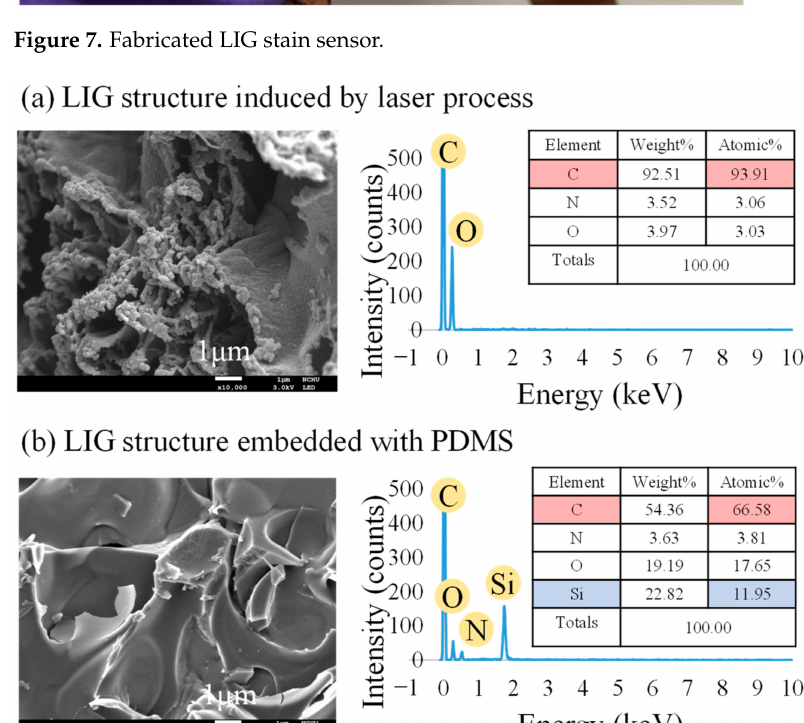
Figure 8. SEM images and EDS results for ( a ) the LIG structure and ( b ) the LIG structure embedded in